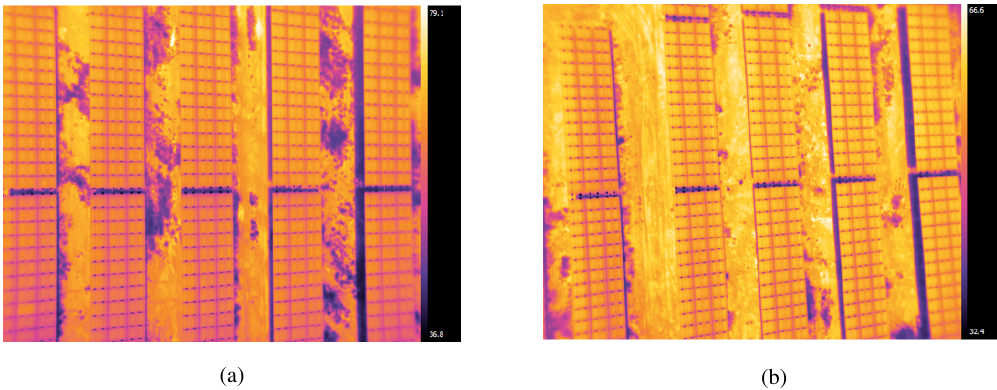
Figure 1. DCNN image classification pipeline.